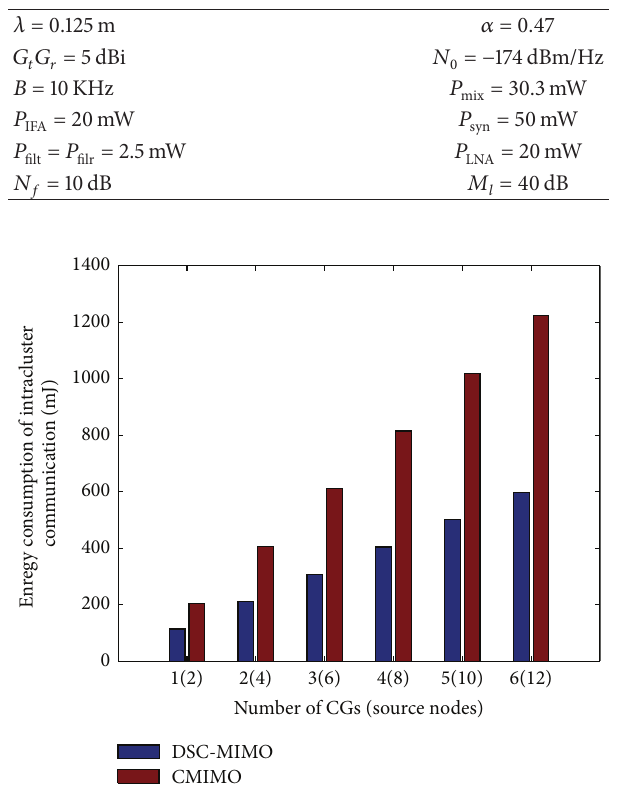
Figure 5: The energy consumption of DSC-MIMO and CMIMO in intracluster communication phase.